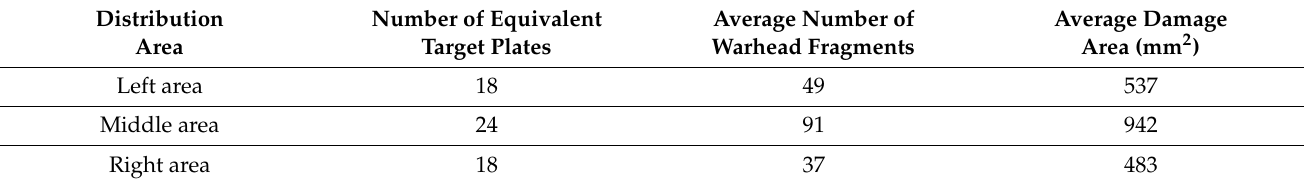
Table 4. Test data when the intersection angle is about 5.9 ◦ , and the intersection distance is 40.4